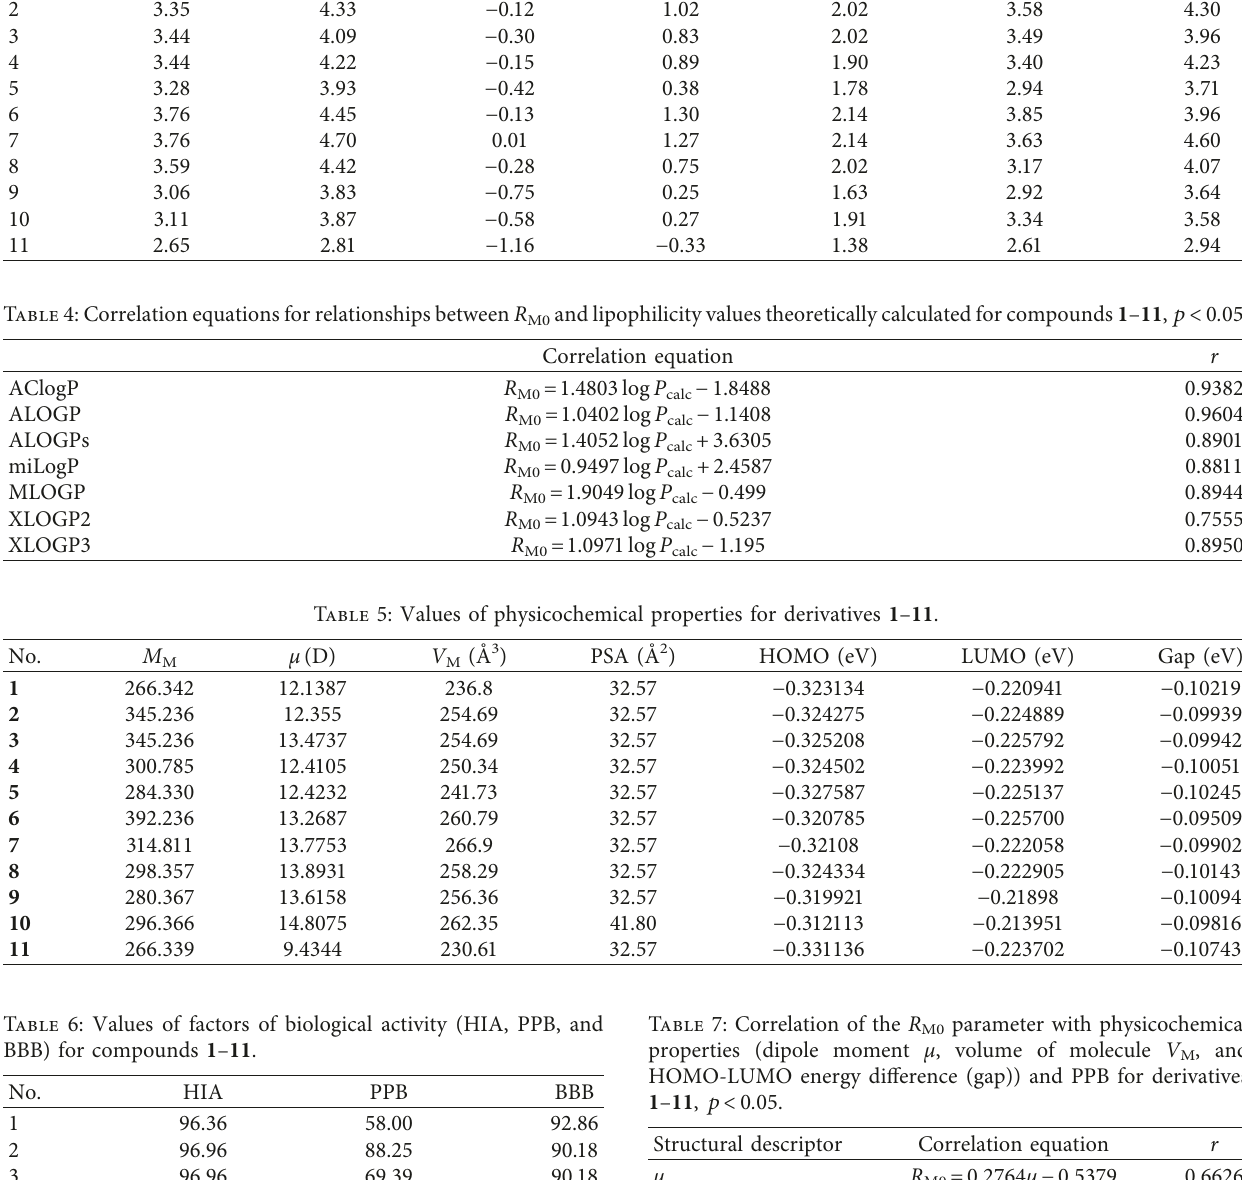
Table 3: Values of lipophilicity parameters of 5-methyl-12 ( H )-quin [3,4- b ] pyrido [2,3- e ] [1, 4] thiazine salts 1–11 obtained using computer methods.